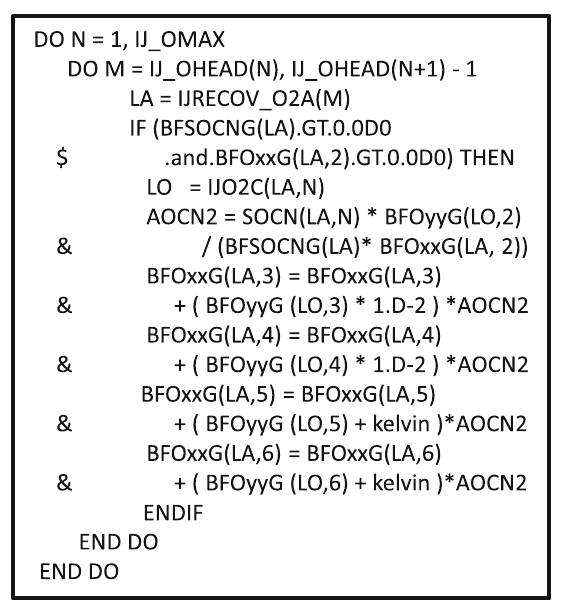
Fig. 6 A part of MIROC interpolation code. Owing to the design of Jcup, this code could be ported directly to the Jcup interpolation